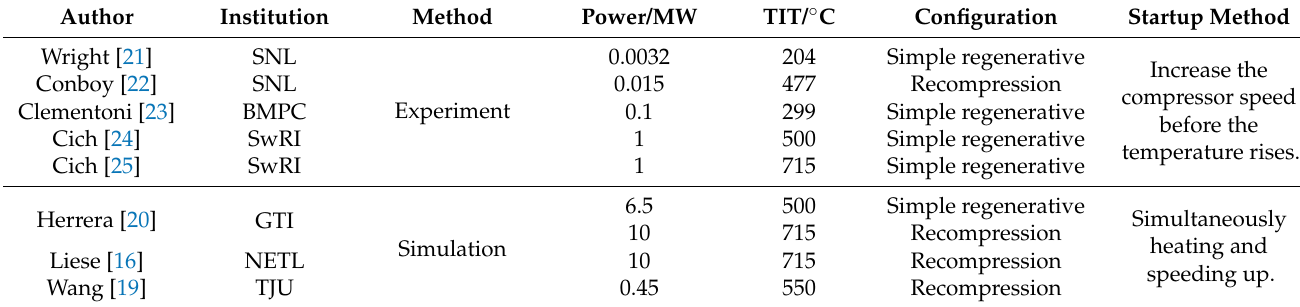
Table 1. Existing research on the startup